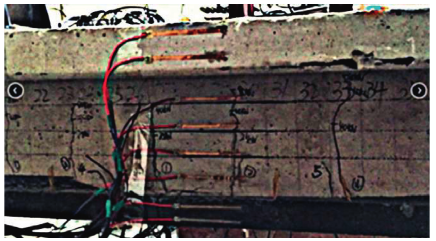
Figure 5: Distribution of strain gauge along beam